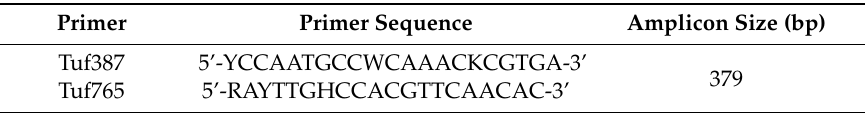
Table 1. Sequence and amplicon size of the Tuf387 / 765 primer